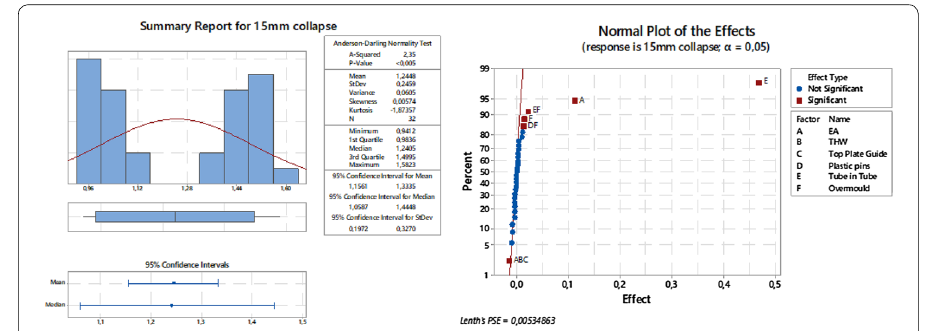
Fig. 13 Summary report for 15 mm collapse